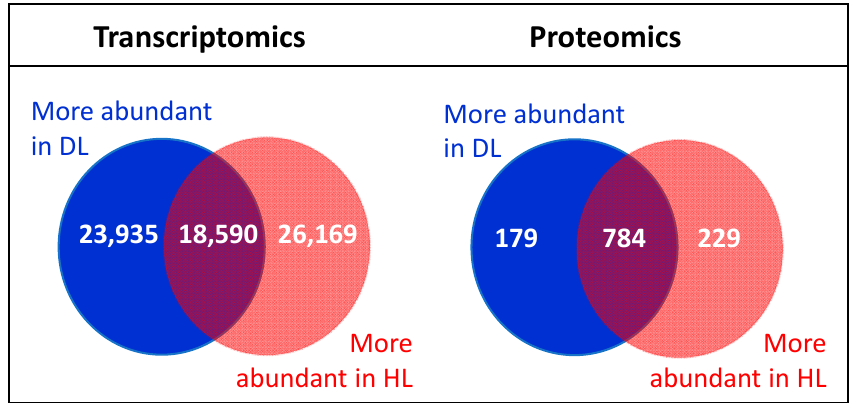
Figure 1. Identified differentially expressed genes (DEGs) and differentially abundant proteins (DAPs) between R. serbica HL and DL.